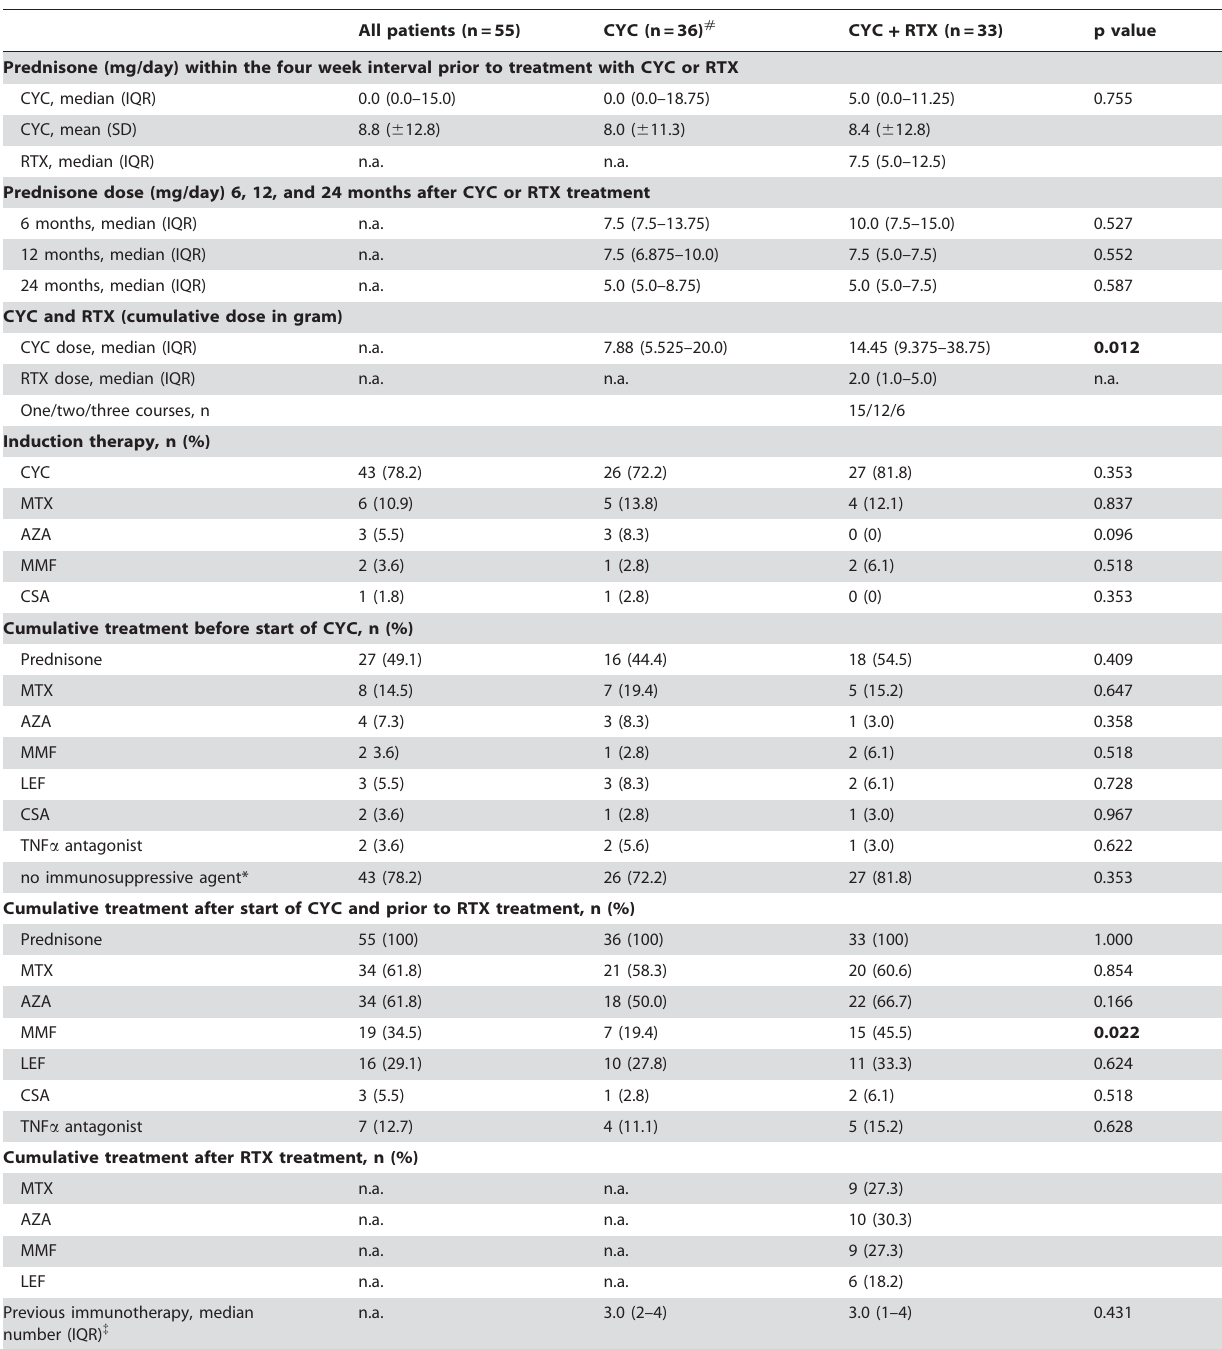
Table 2. Treatment characteristics of the AAV cohort.